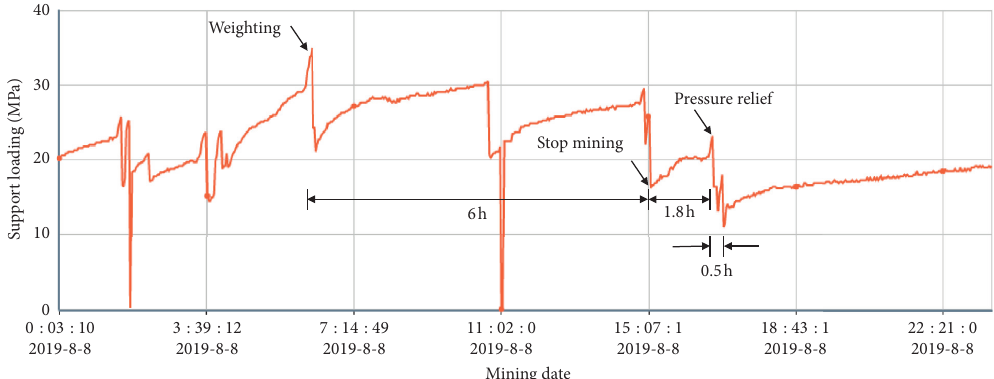
Figure 9: Load distribution on the support on 8 August